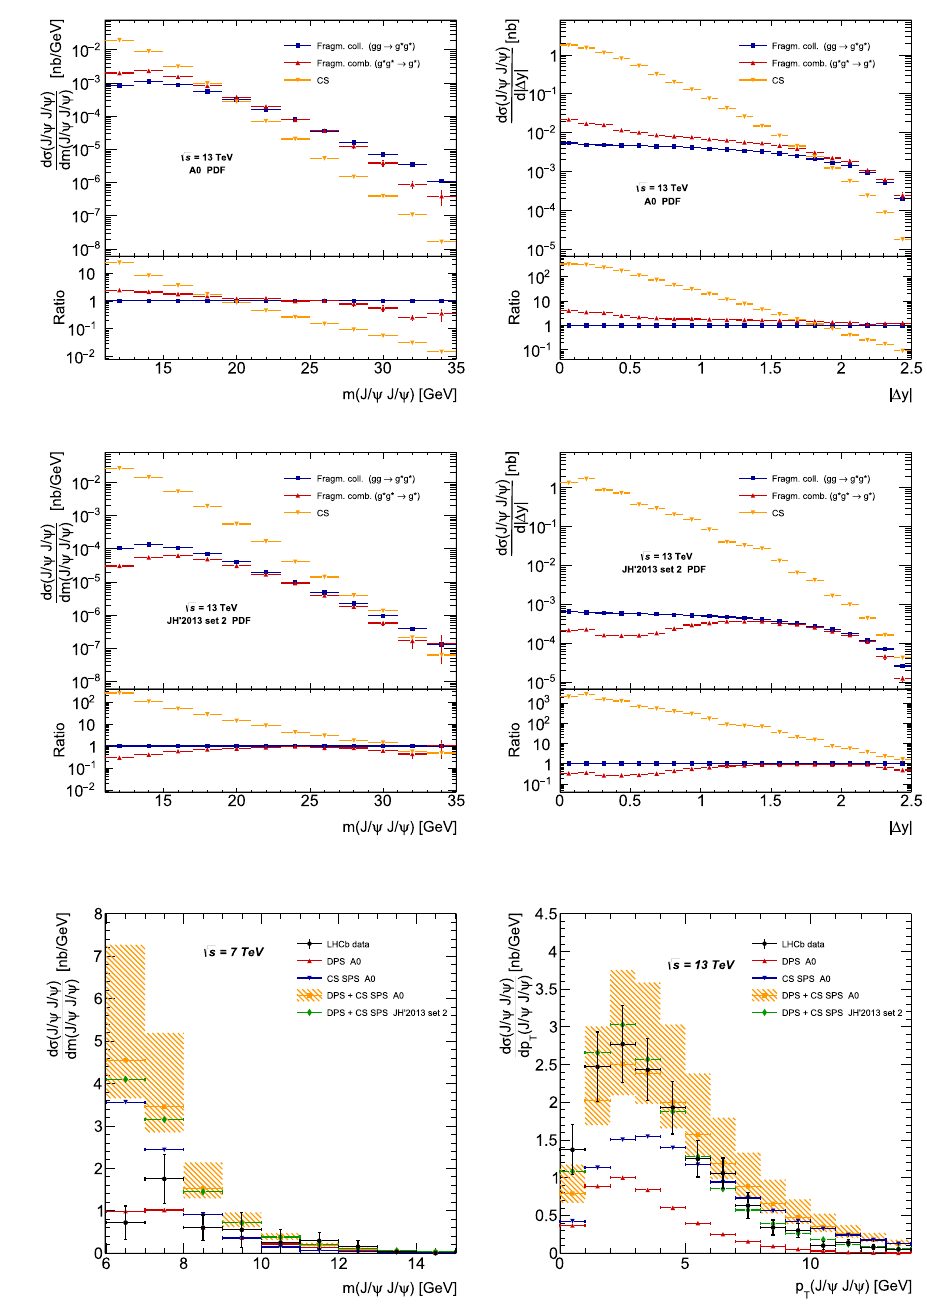
to the double J /ψ production calculated as functions of invariant mass m ( J /ψ, J /ψ) and rapidity separation | (cid:6) y ( J /ψ, J /ψ) | at √ s = 13 TeV. The kinematical cuts 4 . 5 < p T ( J /ψ) < 10 GeV